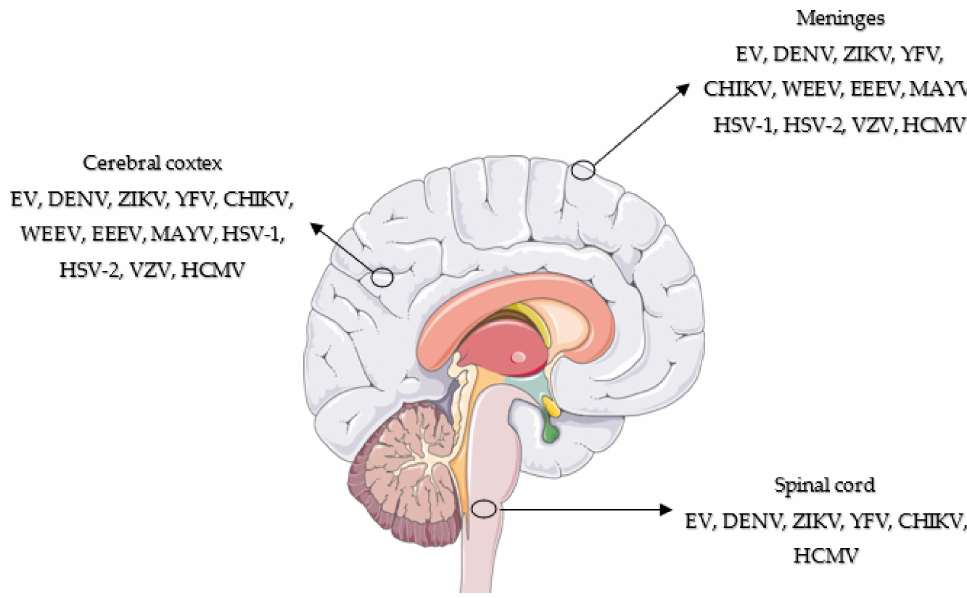
Figure 1. Brain areas commonly associated with viral infection. Enterovirus (EV); Dengue virus (DENV); Chikungunya virus (CHIKV); Human cytomegalovirus (HCMV); Eastern equine encephali- tis virus (EEEV); Herpes simplex virus-1 (HSV-1); Herpes simplex virus-2 (HSV-2); Mayaro virus (MAYV); Varicella-zoster virus (VZV); Western equine encephalitis virus (WEEV); Yellow fever virus (YFV); Zika virus